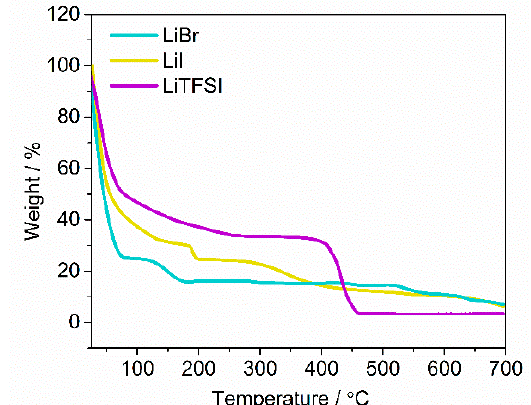
Figure 2. Thermogravimetric analysis (TGA) curves of LiBr, LiI, and LiTFSI electrolytes performed from room temperature up to 700 °C at a heating rate of 10 °C min − 1 .